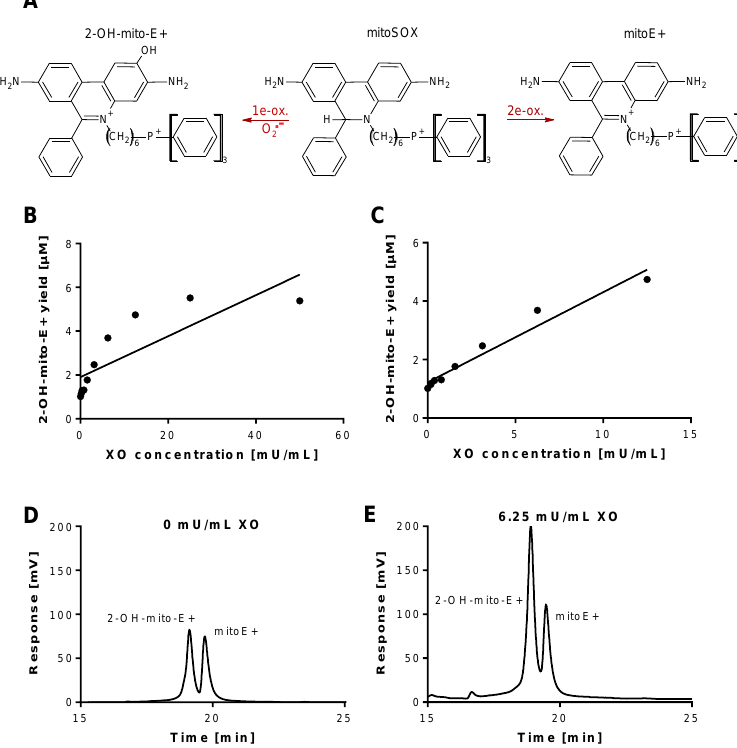
Figure 1. Detection of superoxide generation by xanthine oxidase by mitoSOX HPLC. ( A ) Structures of mitoSOX and its oxidation products 2-OH-mito-E+ (left) and mitoE+ (right). ( B,C ) The yield of the superoxide-specific mitoSOX oxidation product 2-OH-mito-E+ in dependence of the XO concentration (0 – 50 mU/mL). The reaction solution contained 0.1 M potassium phosphate buffer at pH 7.4 and 1 mM hypoxanthine and was incubated for 30 min at 37 °C. ( D,E ) Representative chromatograms are shown for the control without XO and the 6.25 mU/mL XO concentration. A single data point was obtained for each XO concentration. HPLC: high-performance/pressure liquid chromatography; mitoSOX: mitochondria-targeted fluorescence dye triphenylphosphonium-linked hydroethidium.